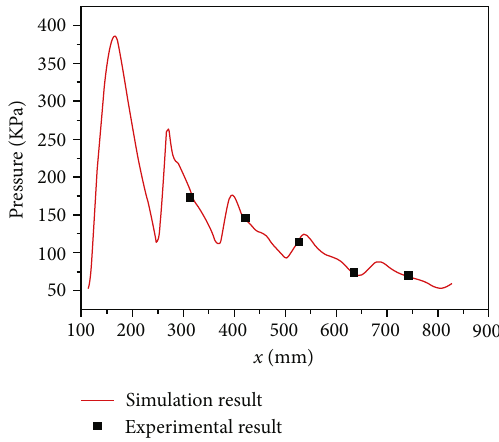
Figure 8: Comparison between the experimental result and numerical